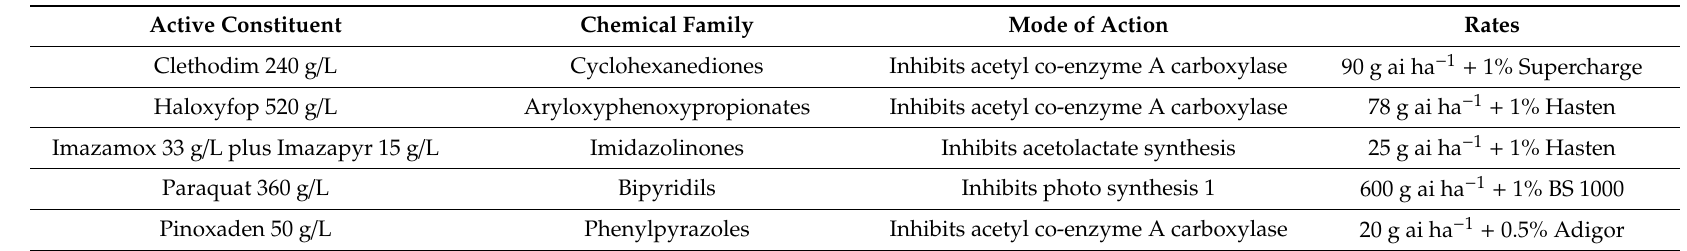
Table 2. Details of herbicides used as alternatives to glyphosate.